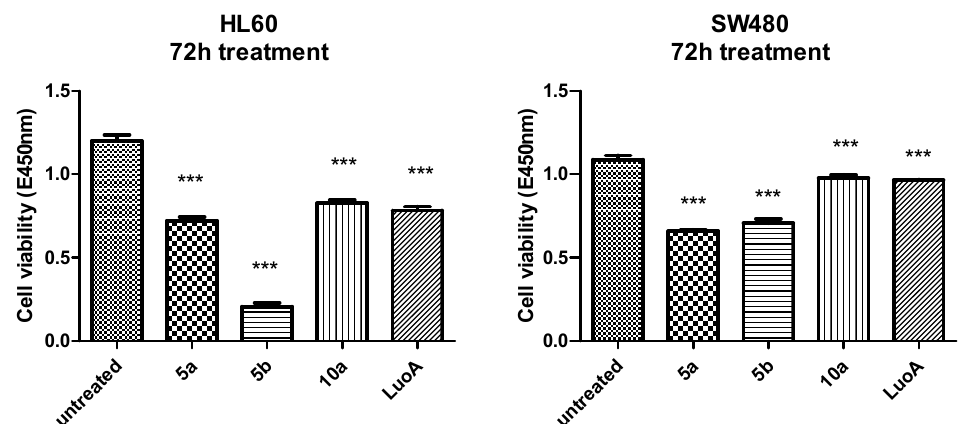
Figure 2. Cell viability screening; cells were treated with the indicated compounds at 40 µ M, after 72 h of incubation the MTT assay was conducted, showing compound 5b as significantly most potent in HL60 cells. Significance was designated as *** for P < 0.001. Error bars depict ± SD. A dose-response relationship was examined for both Luotonin A and 5b for the two examined cell lines. An IC 50 of 7.17 ± 1.07 µ M was calculated for 5b in HL60 cells, whereas an IC 50 for SW480 could